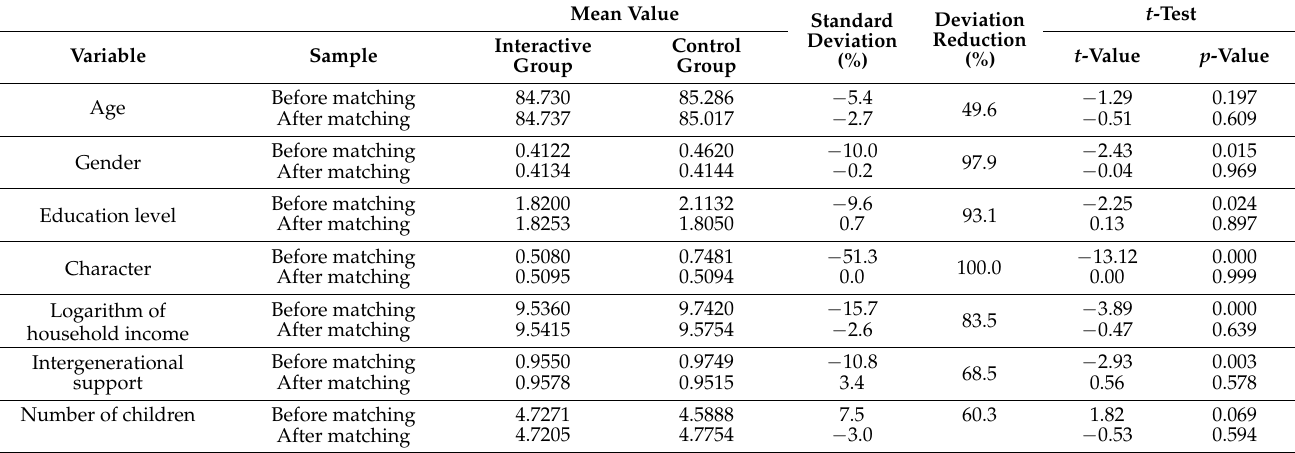
Table 7. Changes of characteristic variables before and after sample matching (Radius).